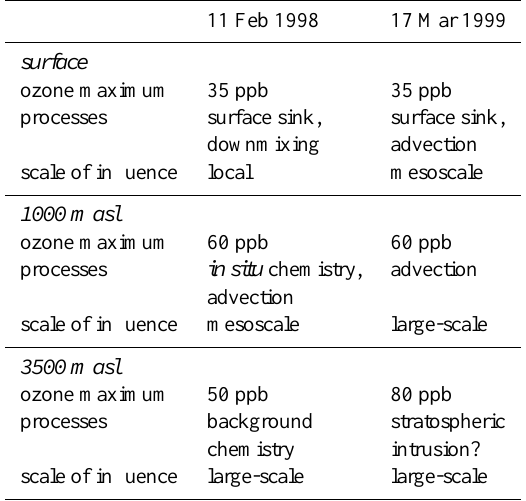
Table 1. Main characteristics of the two ozone episodes, dominat- ing processes governing the ozone variability, and involved spatial scales at three